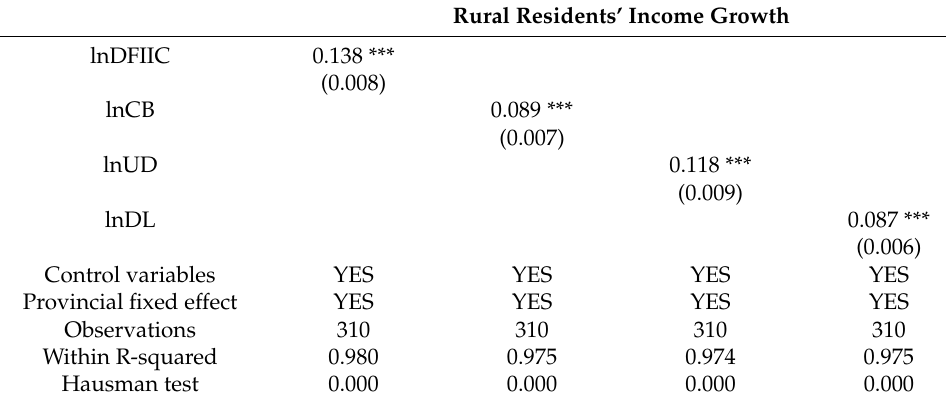
Table A1. Impact of inclusive digital finance during the period of